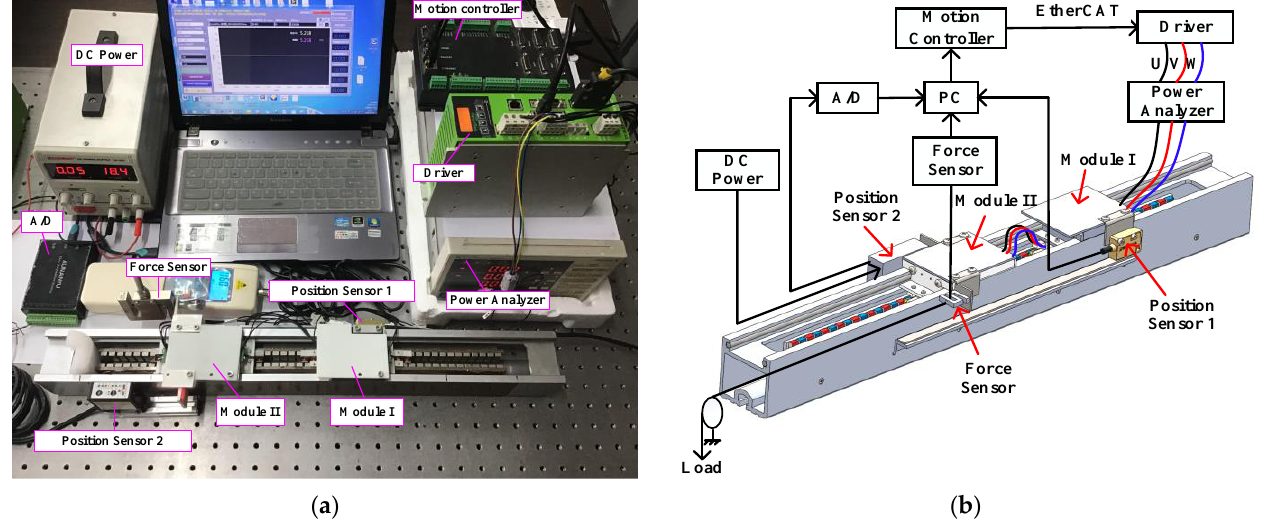
Figure 4. ( a ) Test platform of the two-module PMLSM . ( b ) Schematic diagram of the test